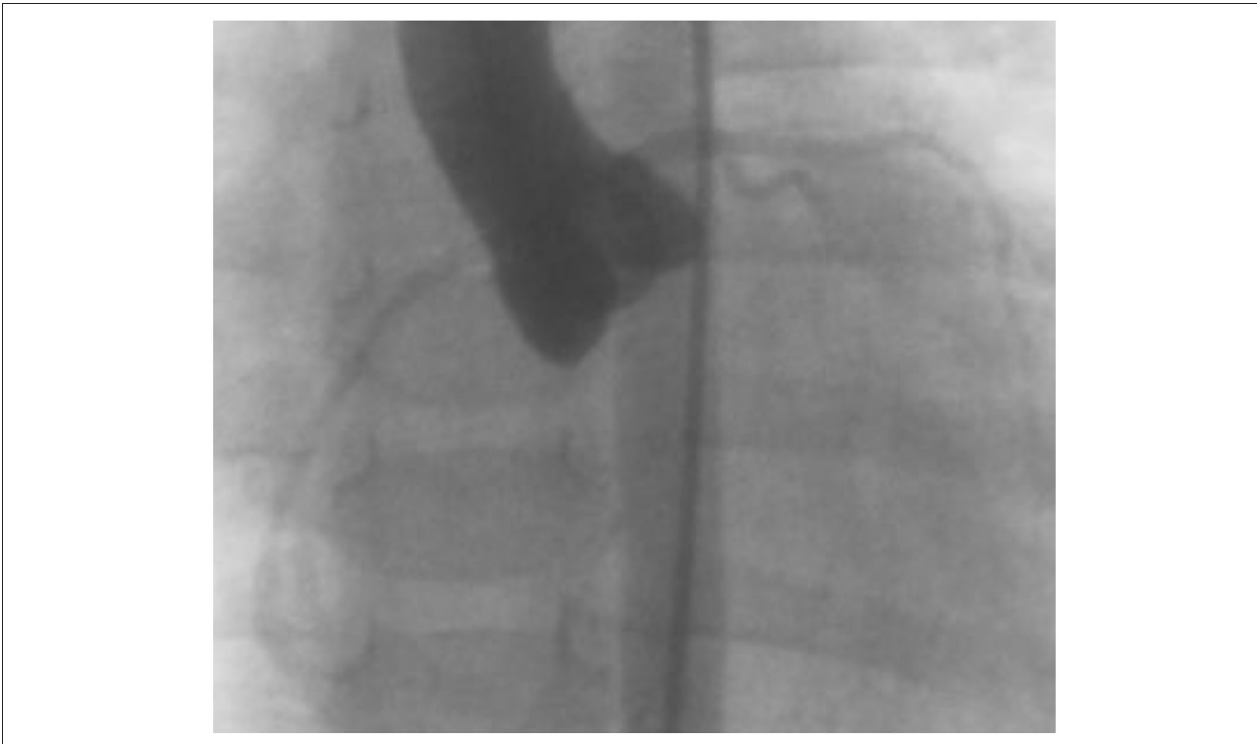
FIGURE 1 | An aortic angiogram showing no coronary artery